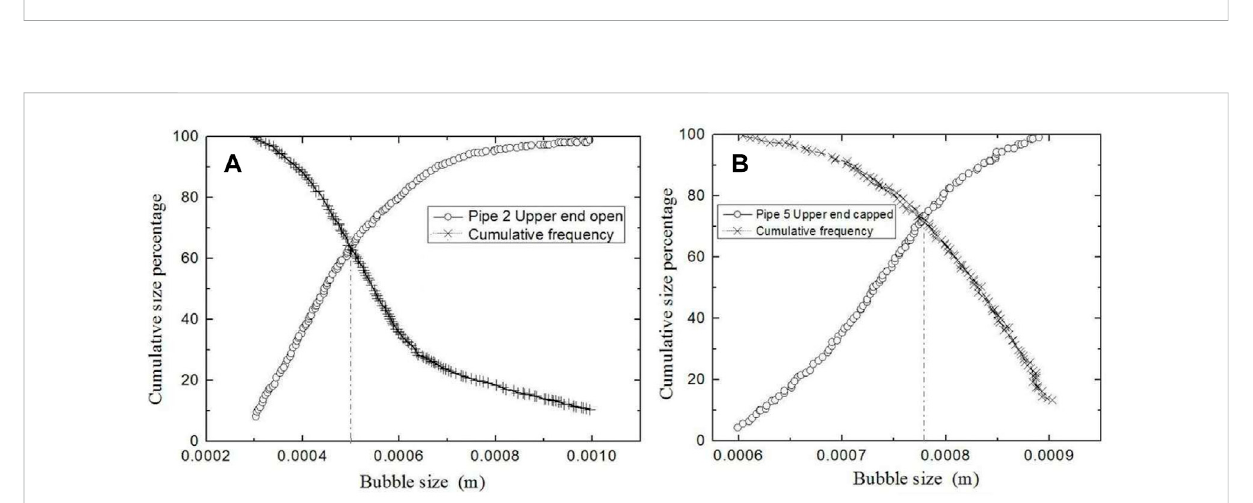
FIGURE 10 Cumulative distribution (CD) of bubble sizes (open circles) and cumulative frequency (crosses): (A) for Pipe 2 with top open and (B) for Pipe 5 with top closed. The dot-dashed vertical line in each frame marks the average bubble